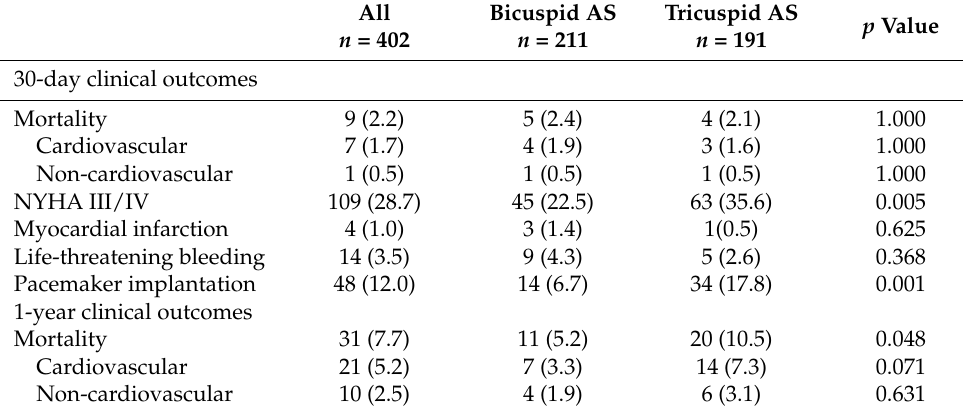
Table 3. Clinical outcomes during 30-day and 1-year